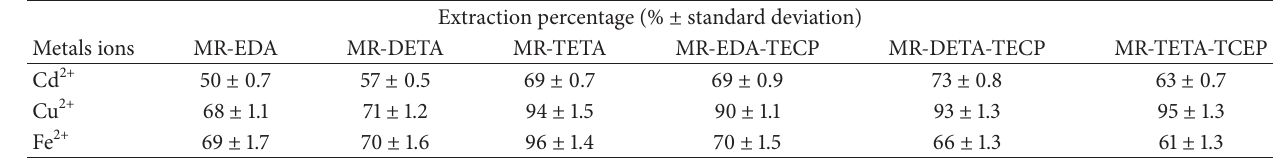
Table 3: Extraction percentage results of metal ions by the synthesized